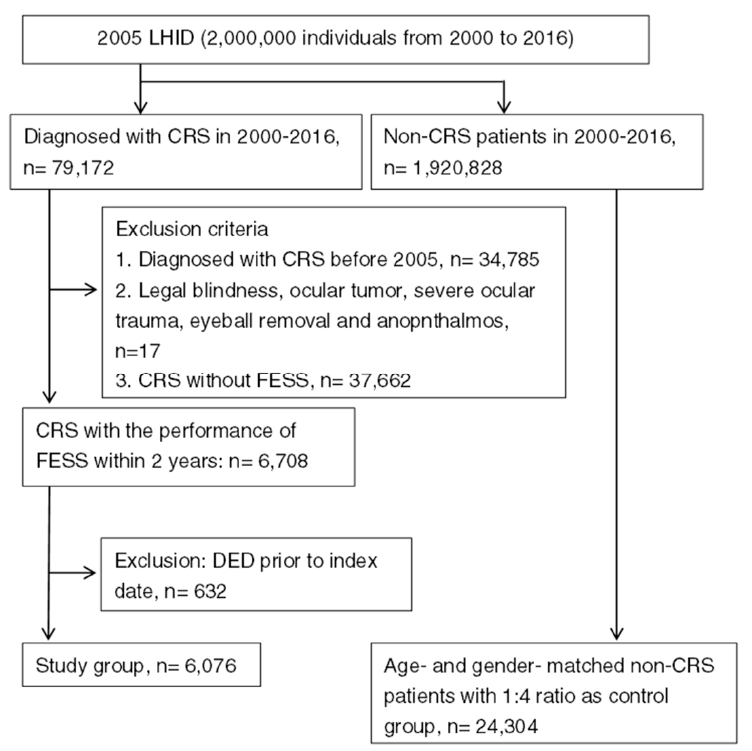
Figure 1. The flowchart of patient selection. LHID 2005: Longitudinal Health Insurance Database 2005 version, CRS: chronic rhinosinusitis, FESS: functional endoscopic sinus surgery, DED: dry eye disease. Table 1. Di ff erent characteristics of co-morbidities between the study and control